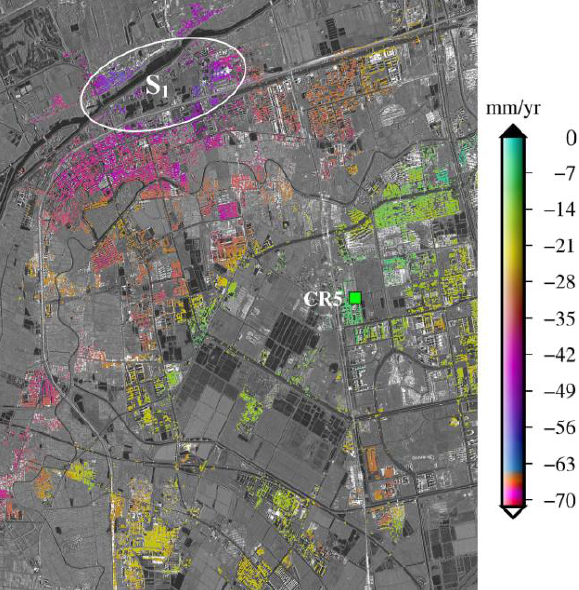
Figure 3. Distribution of subsidence rates estimated at 91601 valid pixels identified from Group 0 with ADI values of (0.4, 0.5]. An oval labeled by S 1 is marked for a subsidence trough that corresponds to a thermal power plant.